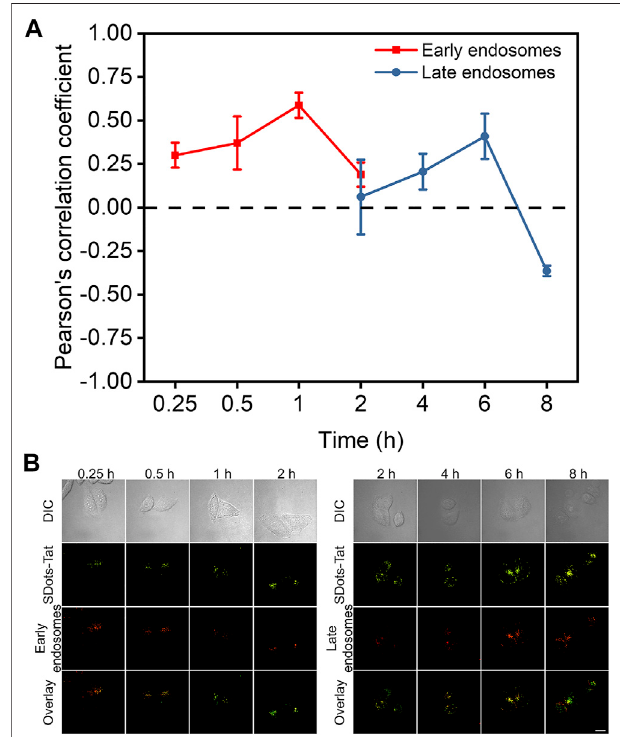
FIGURE 2 | Colocalization studies of SDots-Tat with two speci fi c types of endosomes, i.e., early endosomes and late endosomes. (A) Quanti fi cation of the degree of colocalization by Pearson ’ s correlation coef fi cient (PCC) analysis based on confocal fl uorescent images. The PCC values range between -1 and 1. A larger PCC value indicates a greater degree of colocalization. PCC = 1 corresponds to perfect correlation